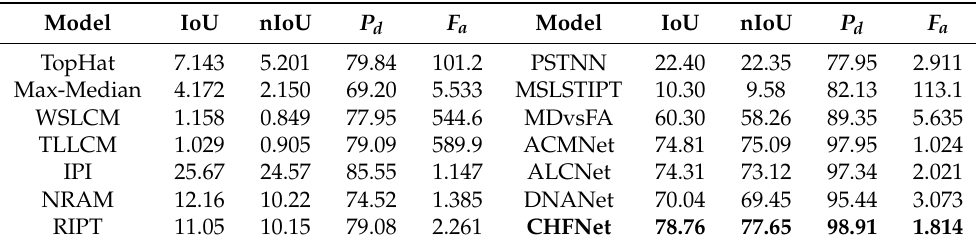
Table 1. Comparison of the IoU (%), nIoU (%), P d (%), and F a (10 − 5 ) for different detection methods on NUAA-SIRST.